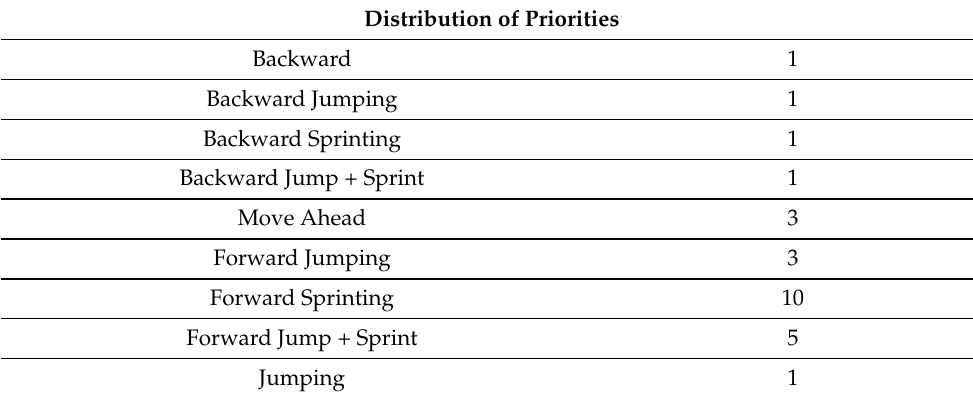
Table 3. Distribution of